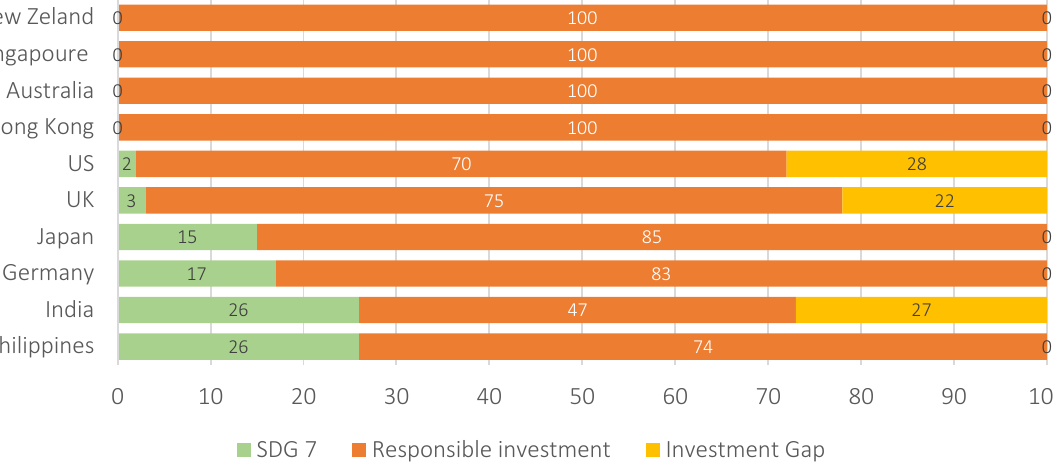
Figure 7. Internet users’ interest in SDG 7, Responsible investment and Investment Gap in 2004–2022: top 10 countries,